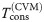
The consensus distribution and consensus time in the CVM.Numeric results confirm that these properties of the CVM depend only on m (defined in Eq 2), the initial strength of the red opinion. (In the plot, we have deliberately added jitter in the horizontal direction to make individual data points visible. Otherwise the overlap would obscure that there are multiple points on top of each other.) Each symbol shows the mean of 1000 simulations. All simulations use e = 1/4 and i = 1/16. N, c, and the initial conditions vary. (N is symbolized by the size, c by the shape, and the initial condition by the color; see legend.) (A) Proportion of simulations in which the red opinion wins (F) as a function of the initial strength of red [m(t = 0)]. The diagonal line indicates F = m. The overlapping symbols exemplify that simulations with different initial conditions produce the same F if the initial m is the same, despite different abundances of hypocrites. (B) The mean consensus time Tcons(CVM) as a function of m. The gray curves are theoretical predictions from Eq 9, which is derived under the assumption that N is large [53]. The simulations confirm that Eq 9 is a good approximation even for moderately large N. For different N and c, the values of Tcons(CVM) fall on different curves. However, for given N and c, Tcons(CVM) depends only on m, but not on any further details of the initial conditions.